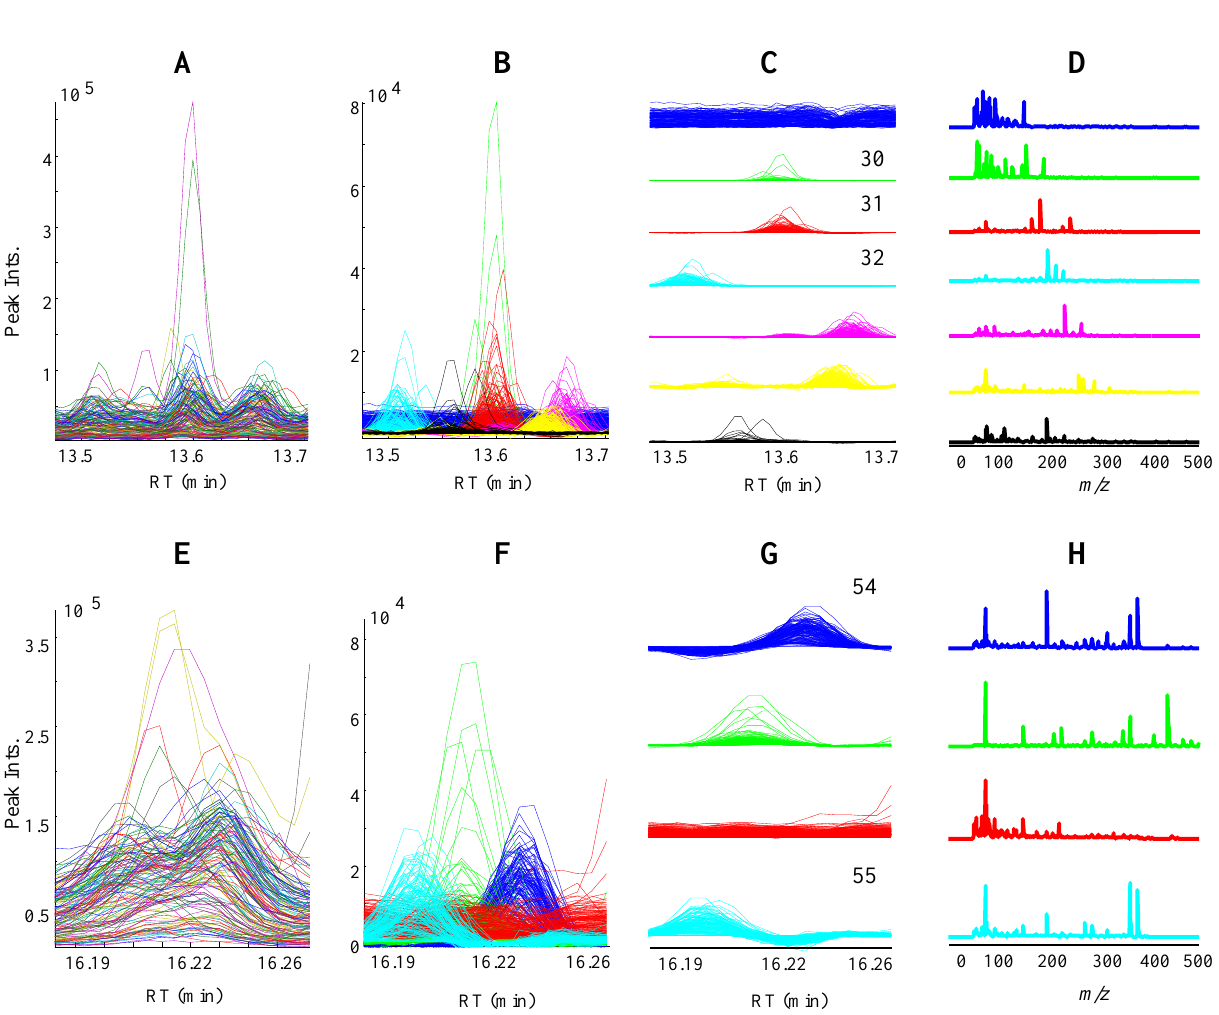
Figure 2. PARAFAC2 based processing of raw GC-MS data intervals. ( A ) and ( E ) are the TIC of raw GC-MS data intervals. ( B ) and ( F ) are the superimposed PARAFAC2 elution profiles of the raw GC-MS data intervals with seven and four components, respectively. ( C ) and ( G ) are subplots of ( B ) and ( F ), respectively. * Numbers of elution profiles correspond to the metabolites represented in Table 1. ( D ) and ( H ) are subplots of PARAFAC2 mass spectral